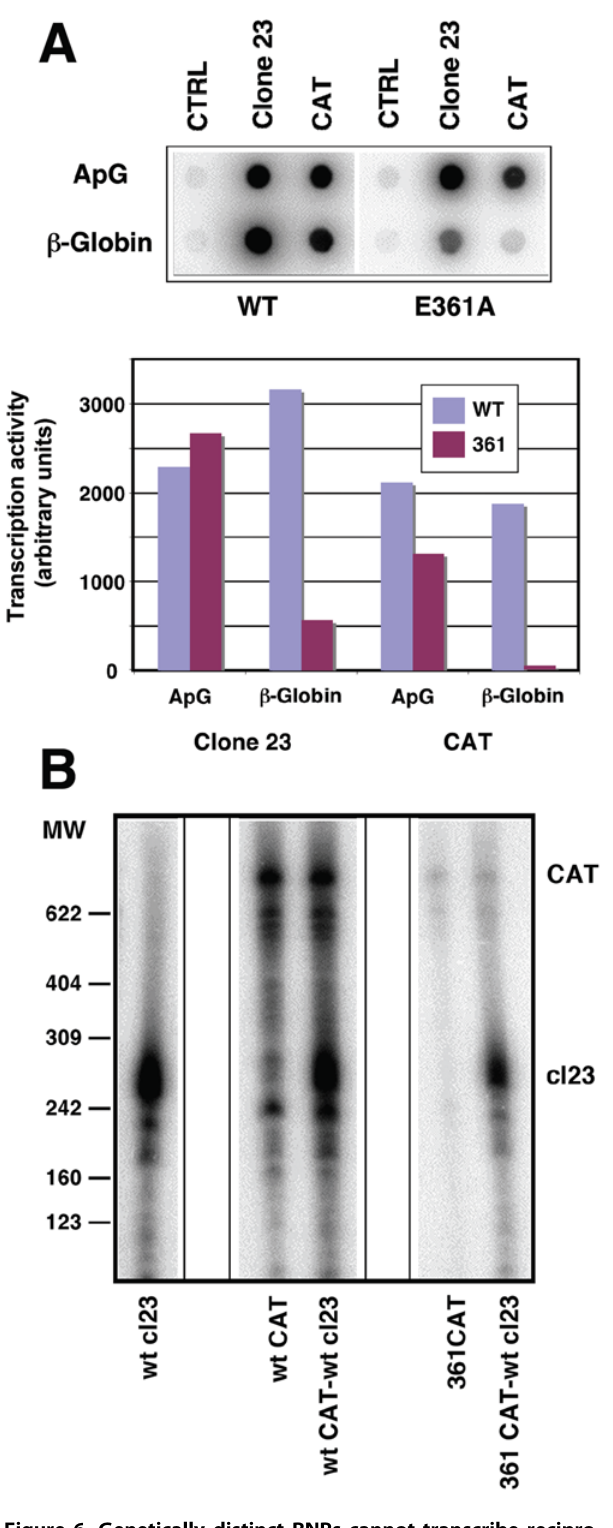
Figure 6. Genetically distinct RNPs cannot transcribe recipro- cally in vitro. (A) Recombinant RNPs were generated by in vivo amplification as described in Materials and Methods and the legend to Fig. 1, using either wt (WT) or transcription-defective (E361A) polymerase. Short (clone 23 -248 nt-), long (CAT -720 nt-) or no (CTRL) RNA replicons were used. The RNPs were purified by Ni 2 + -NTA-agarose chromatography and their transcription activity was determined. Top panel shows the phosphorimager data and bottom panel presents